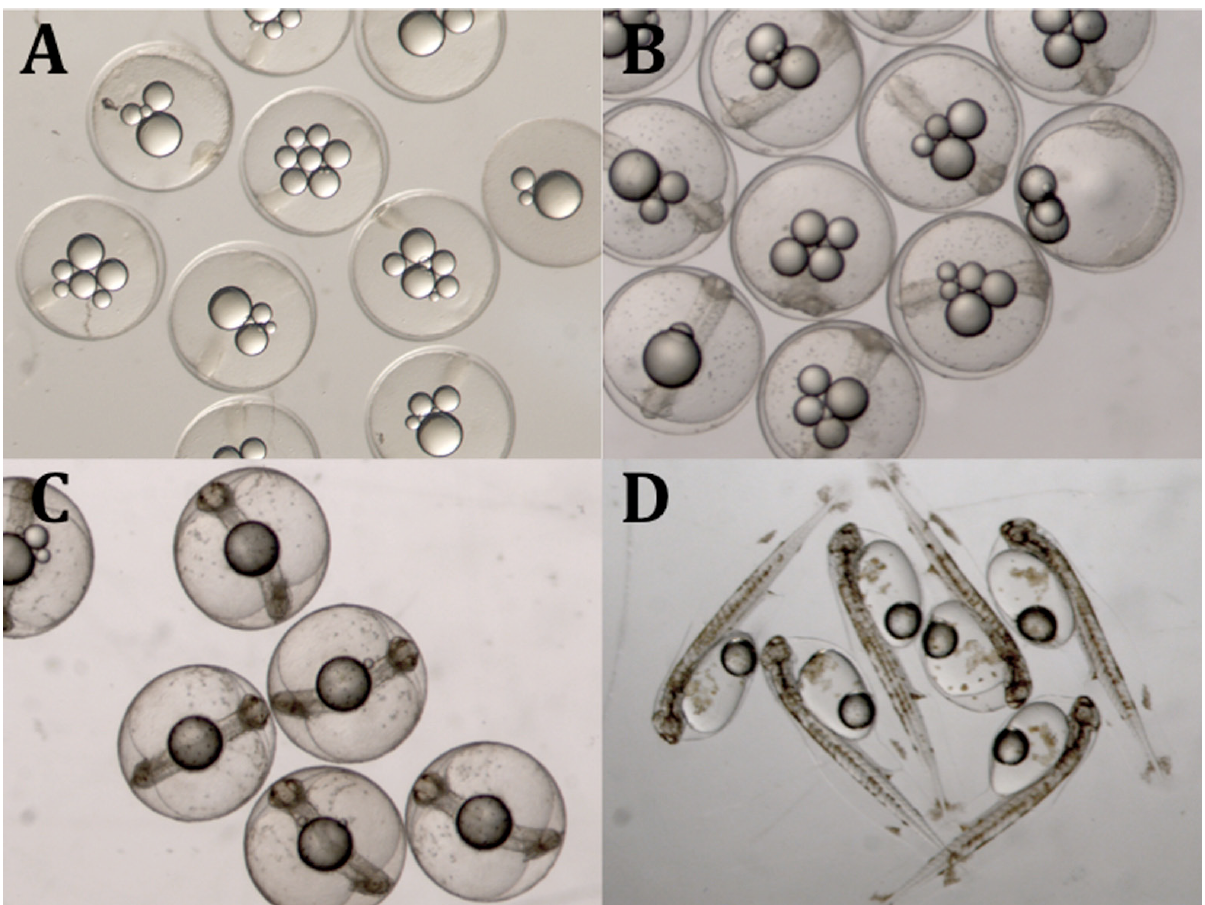
Fig. 1. – Presence and utilization of oil globules in eggs (A to C) and larvae (D) of the Chelon labrosus . A, 24 hours after fertilization (haf); B, 32 haf; C, 48 haf; D, 2 hours post-hatching (hph). Scale bars 1.0